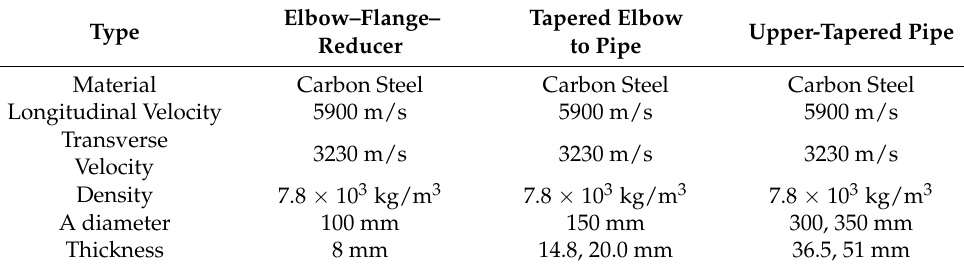
Figure 6. Actual specimens applied to the simulation; ( a ) a pipe with 100 mm diameter flange–elbow structure; ( b ) a pipe with 150 mm diameter tapered elbow structure; ( c ) a pipe with 300 mm diameter tapered upper structure. Table 2. Specifications of the curved pipes used in the simulation.